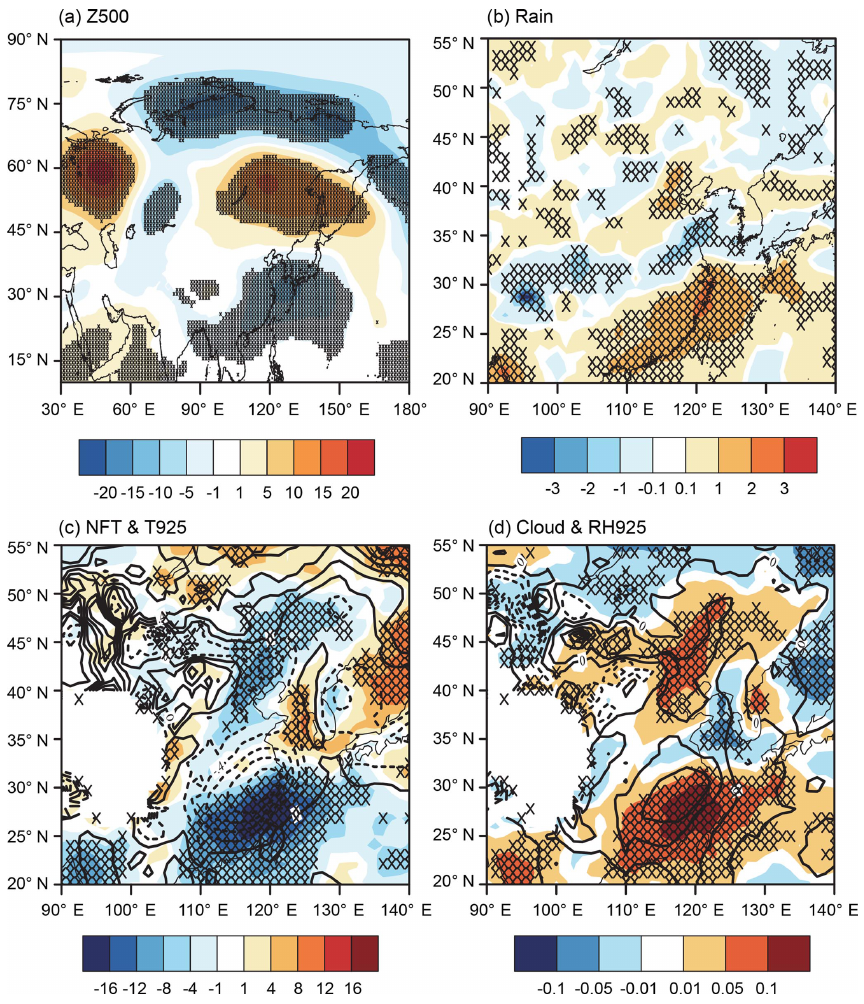
Figure 12. Composite results of the LowASI experiments (LowASI minus CTRL) by the CAM5 model: (a) geopotential height at 500hPa, (b) preciptation, (c) net radiative flux at the top of the atmosphere (shading) and temperature at 925hPa (contour), and (d) sum of low and medium cloud fraction (shading) and relative humidity at 925hPa (contour). The black hatching denotes the differences with shading that was above the 95% confidence level ( t